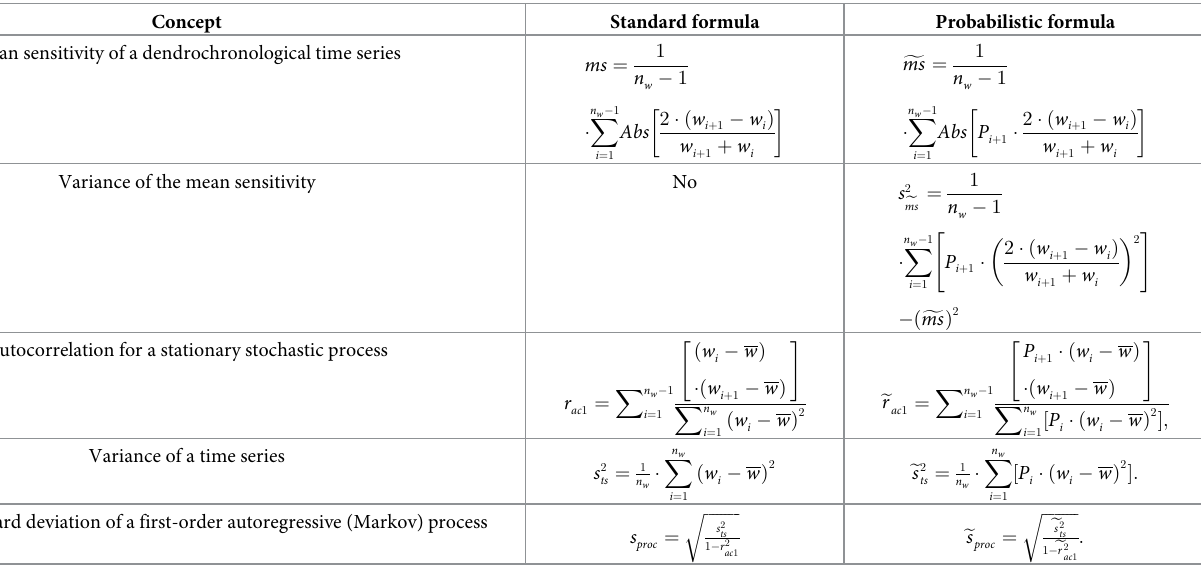
Table 6. Standard and probabilistic formulas for mean sensitivity, autocorrelation, and process standard deviation. Concept Standard formula Probabilistic formula Mean sensitivity of a dendrochronological time series